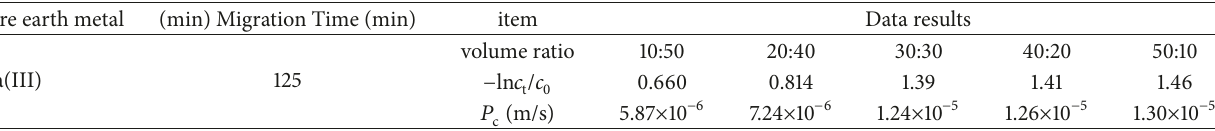
Table 3: Effect of volume ratio of membrane solution and HCl solution on transport of rare earth.